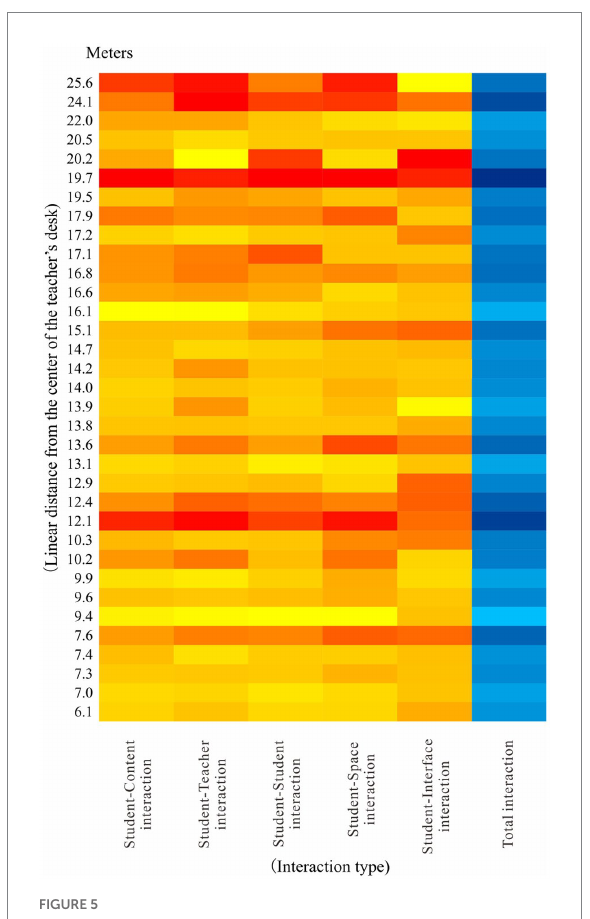
FIGURE 5 Heat map of student interaction preferences at different absolute